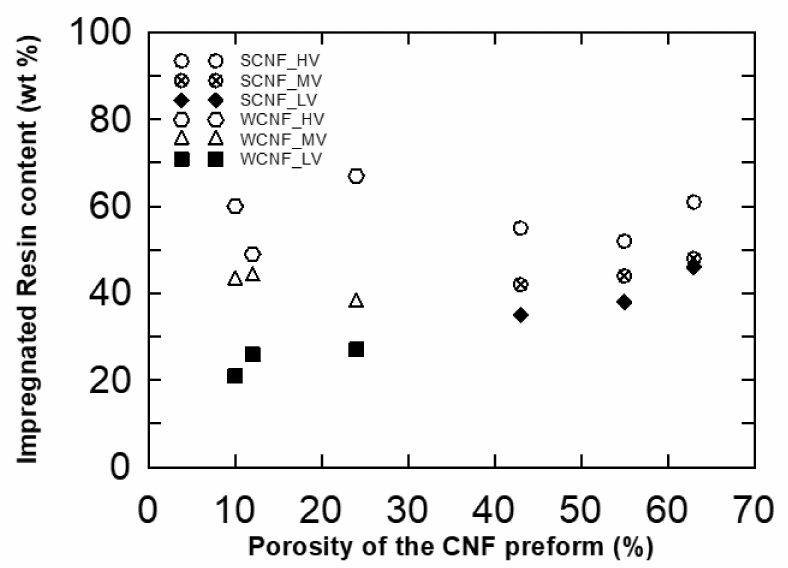
Figure 5. Relationships between CNF preform porosity and the impregnated resin content (wt